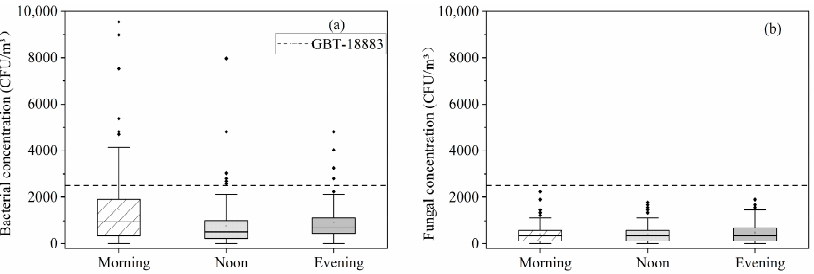
Figure 2. Indoor temperature, R.H. and CO 2 in the tested dormitory.